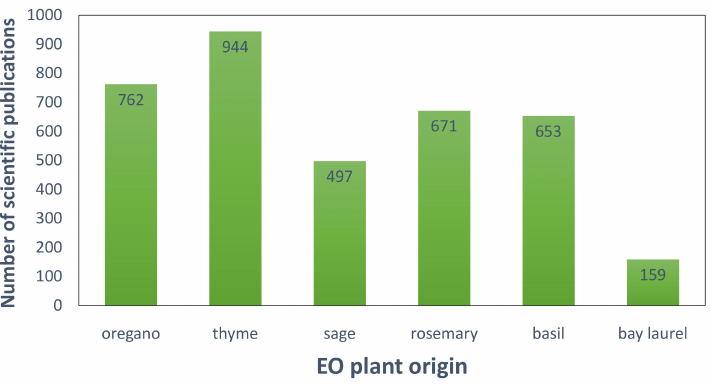
Figure 1. Number of scientific publications for oregano, thyme, sage, rosemary, basil, and bay laurel EOs (retrieved from Scopus on 16 January